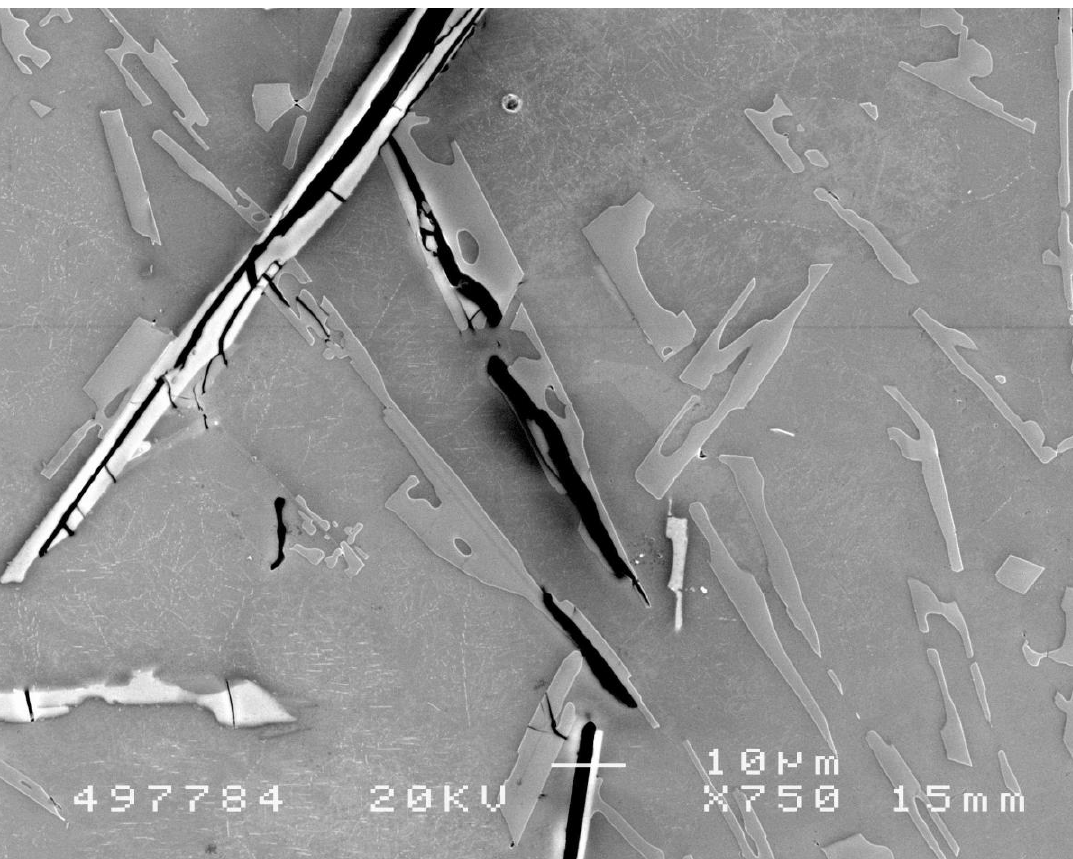
Figure 4. Beta-Fe particle (diagonally upper left) and Si particles (centre) in an Al-Si alloy casting, showing central and transverse cracks, and apparent decoherence from the matrix, consistent with their formation on oxide bifilms, and opening as a result of poor feeding conditions generating a hydrostatic tensile stress (Courtesy X.